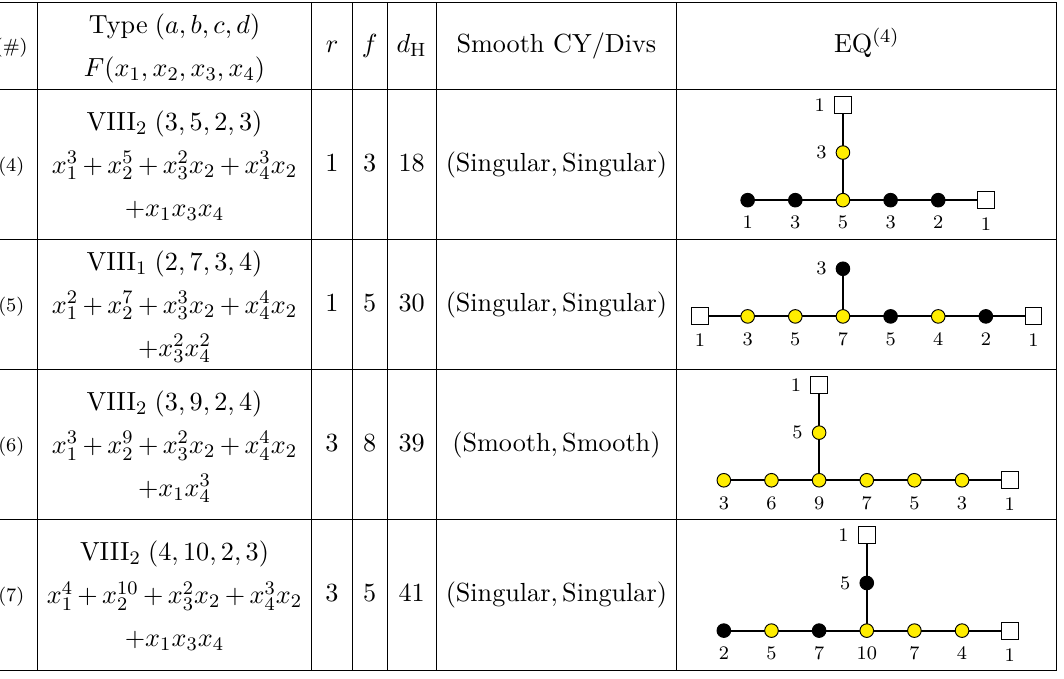
Table 12 . Basic data and EQ (4) for the ‘sporadic’ SU( N ) trinions, continued (2/4).